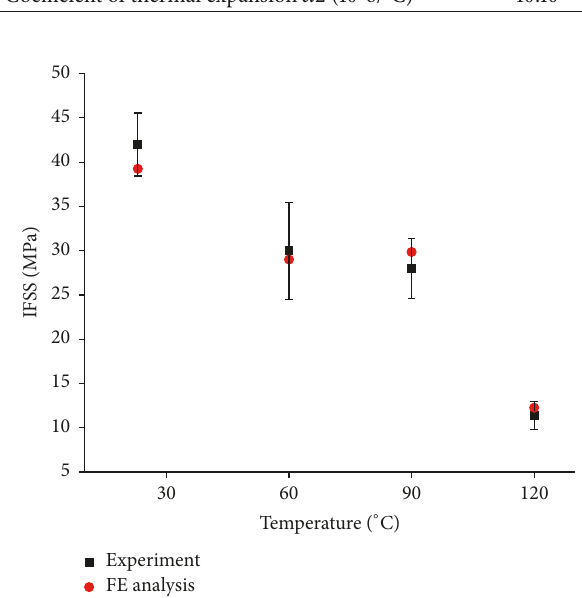
Figure 11: Comparison of apparent IFSS between the simulated and experimental